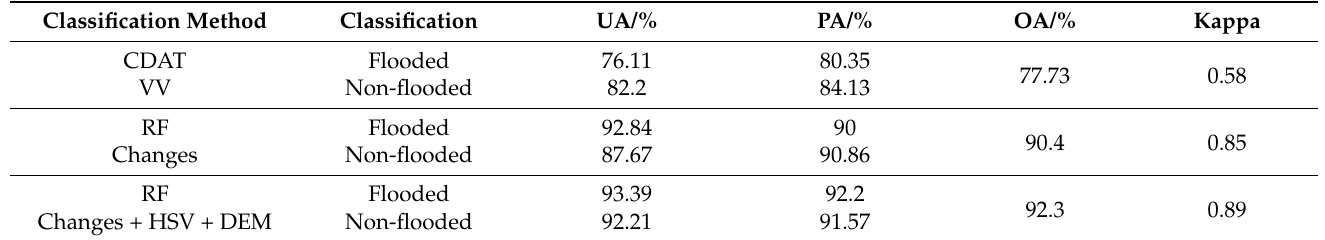
Table 6. Flood mapping accuracy assessment results on the Sentinel-1 SAR date.